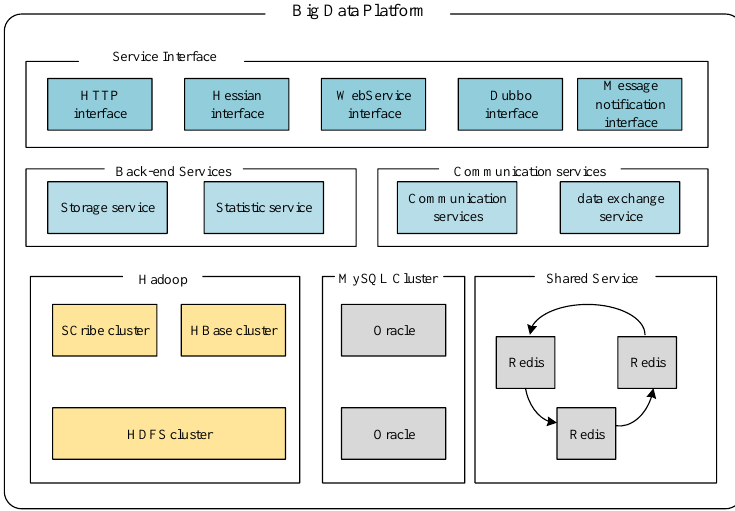
Figure 1. Cloud service platform architecture of big data platform for the National Monitoring and Management Center (NMMC).